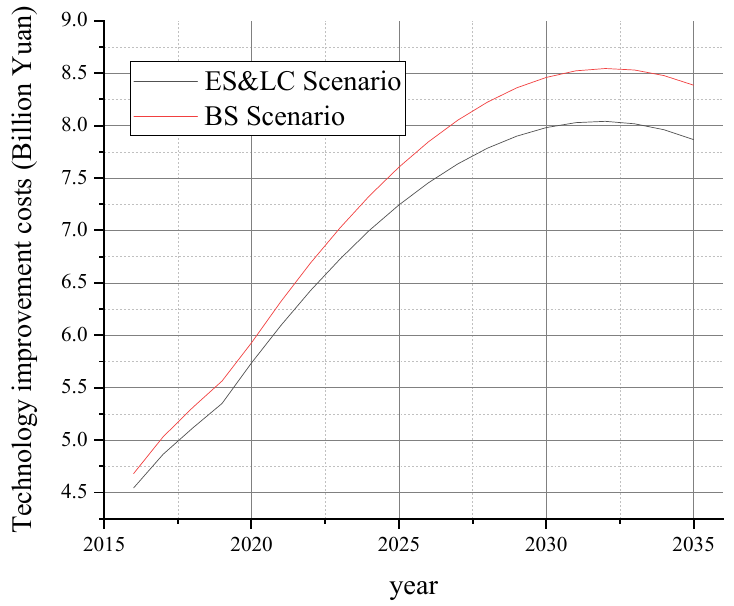
nario and the DO scenario during the whole period, as shown in Figure 5. Figure 4. Technology improvement costs of the ES&LC and BS scenarios. Figure 4. Technology improvement costs of the ES&LC and BS scenarios.